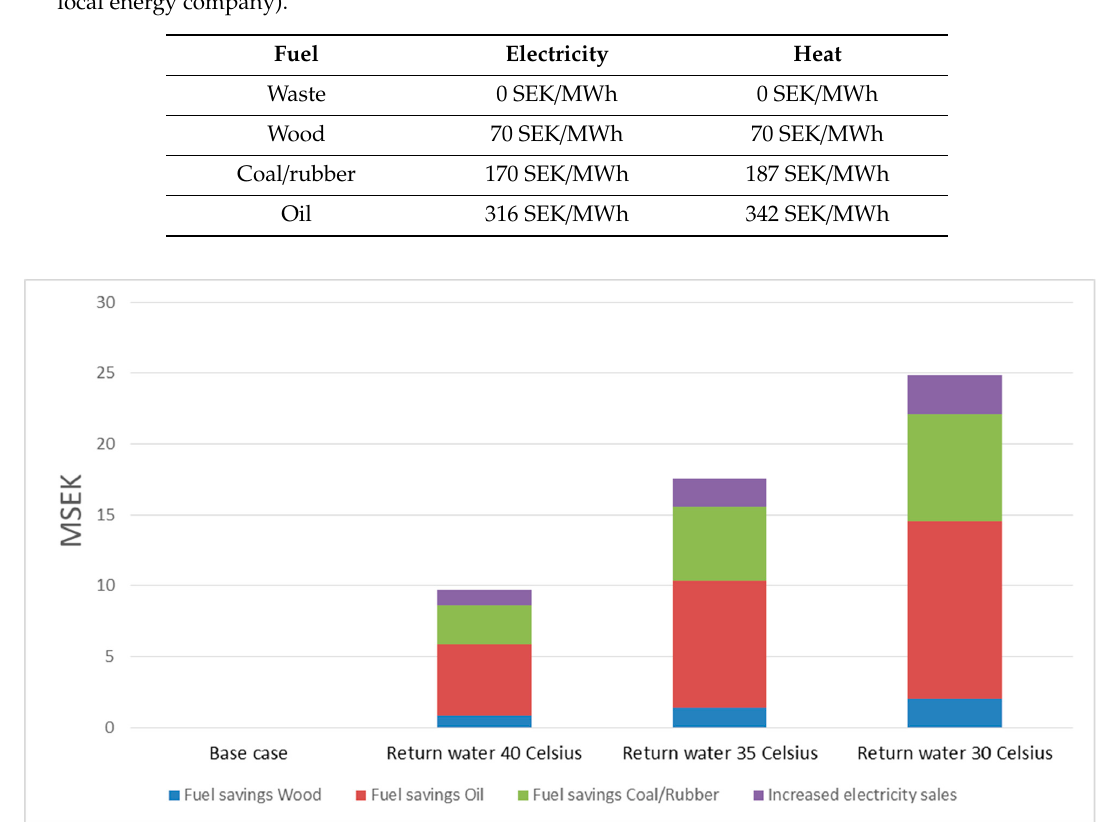
Figure 13. Economic figures for model results, 2015. Costs and earnings from Table 10.